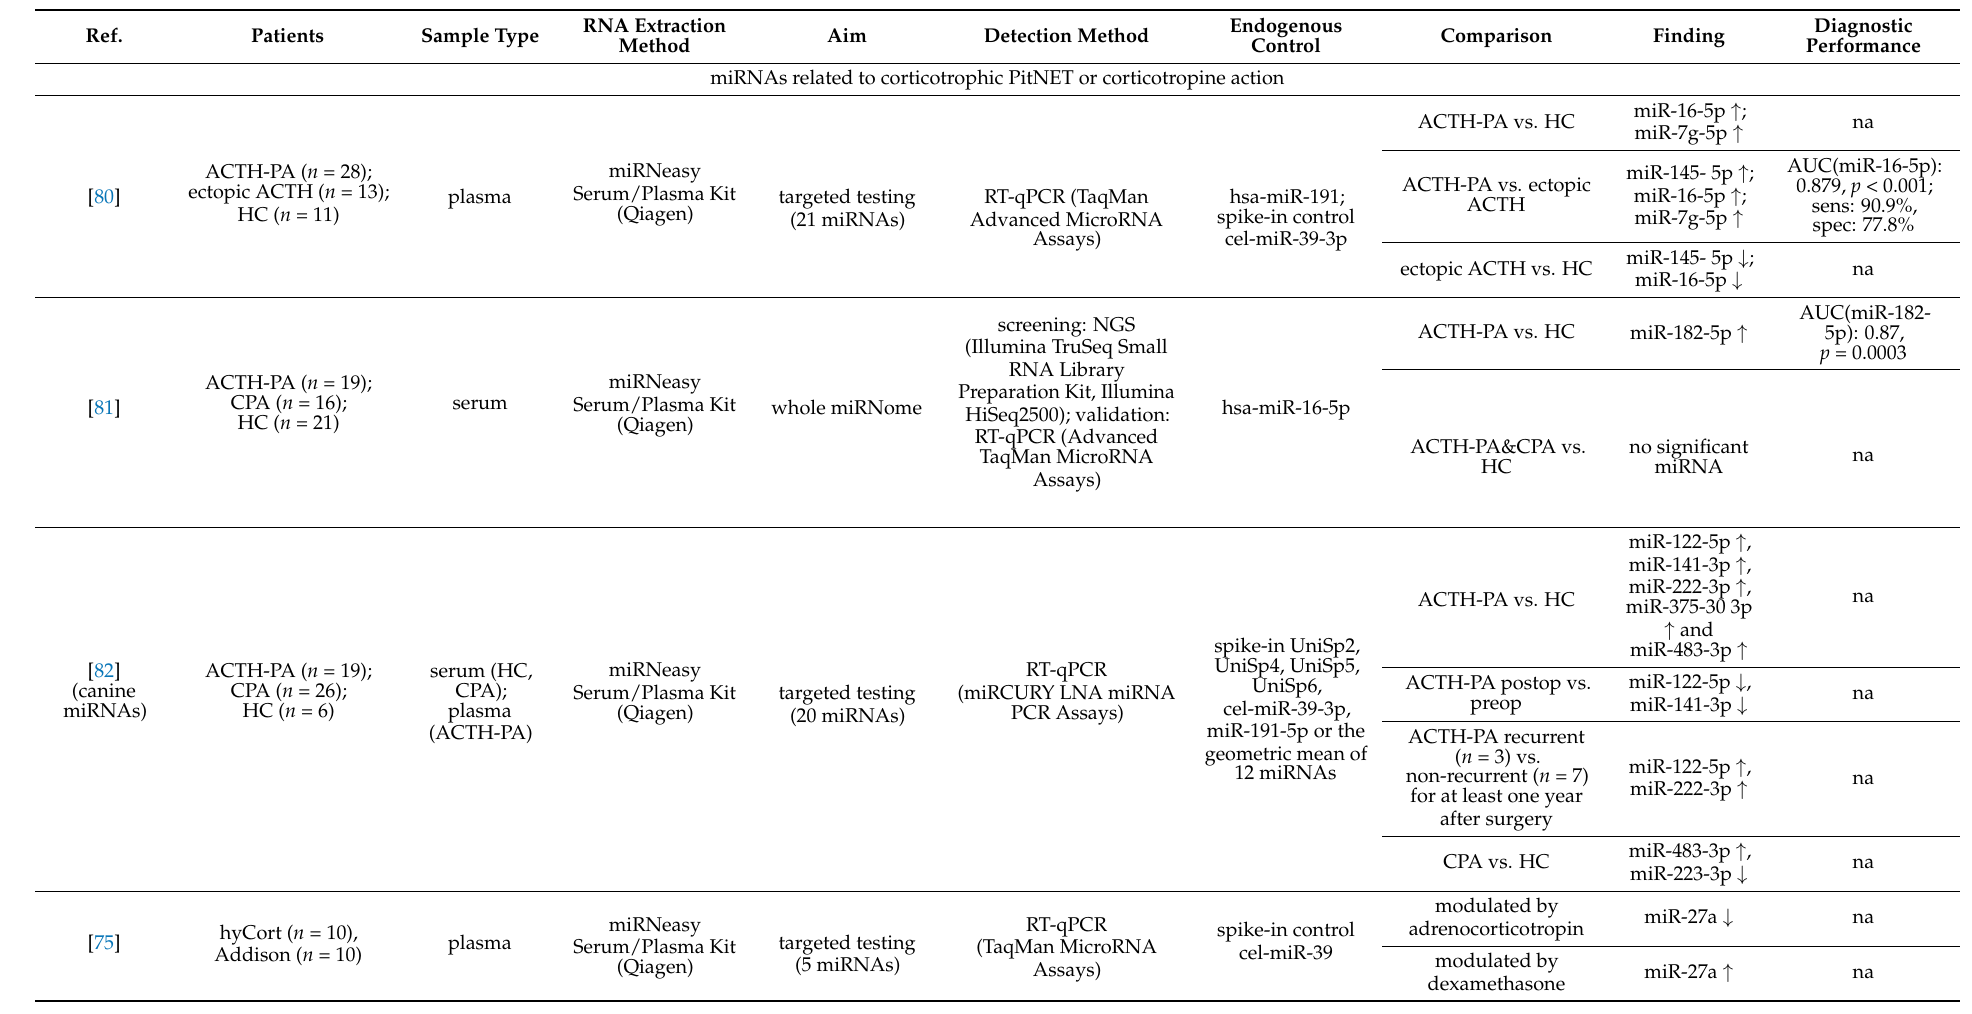
Table 1. Circulating miRNA studies’